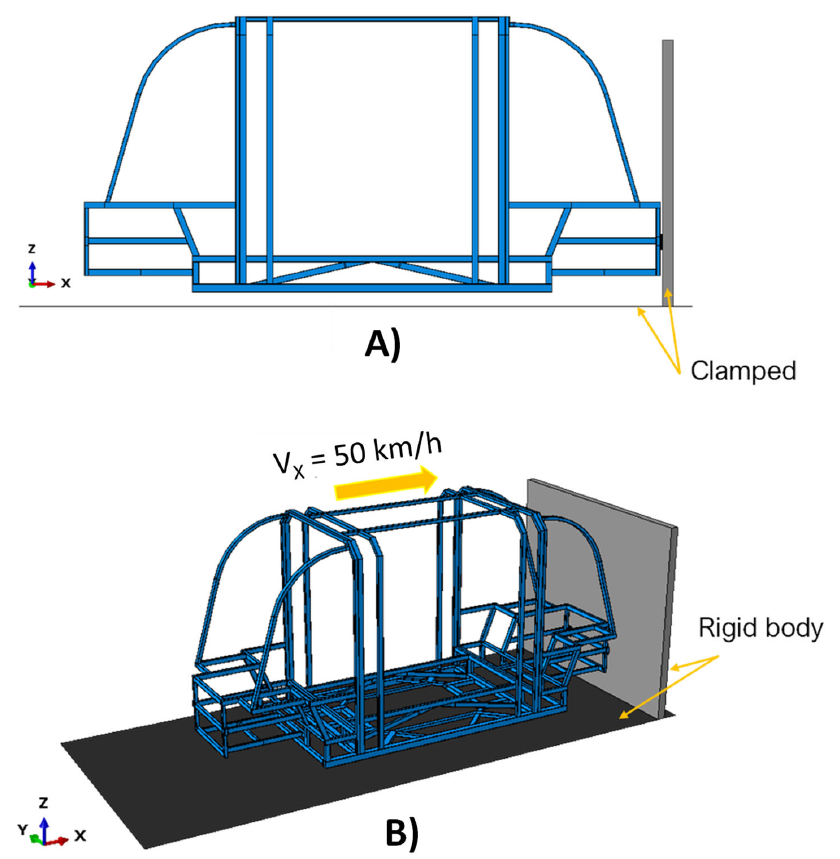
Figure 8. Crash test set-up. ( A ) lateral view, ( B ) isometric view.